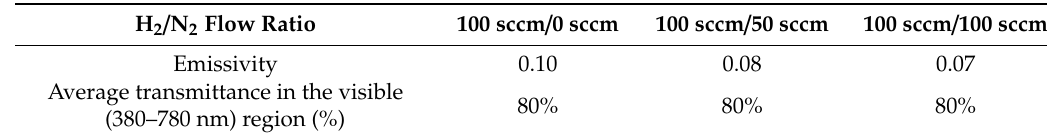
Table 1. Average transmittance in the visible region (380–780 nm) and emissivity of the H 2 /N 2 plasma processed AZO/ITO films.